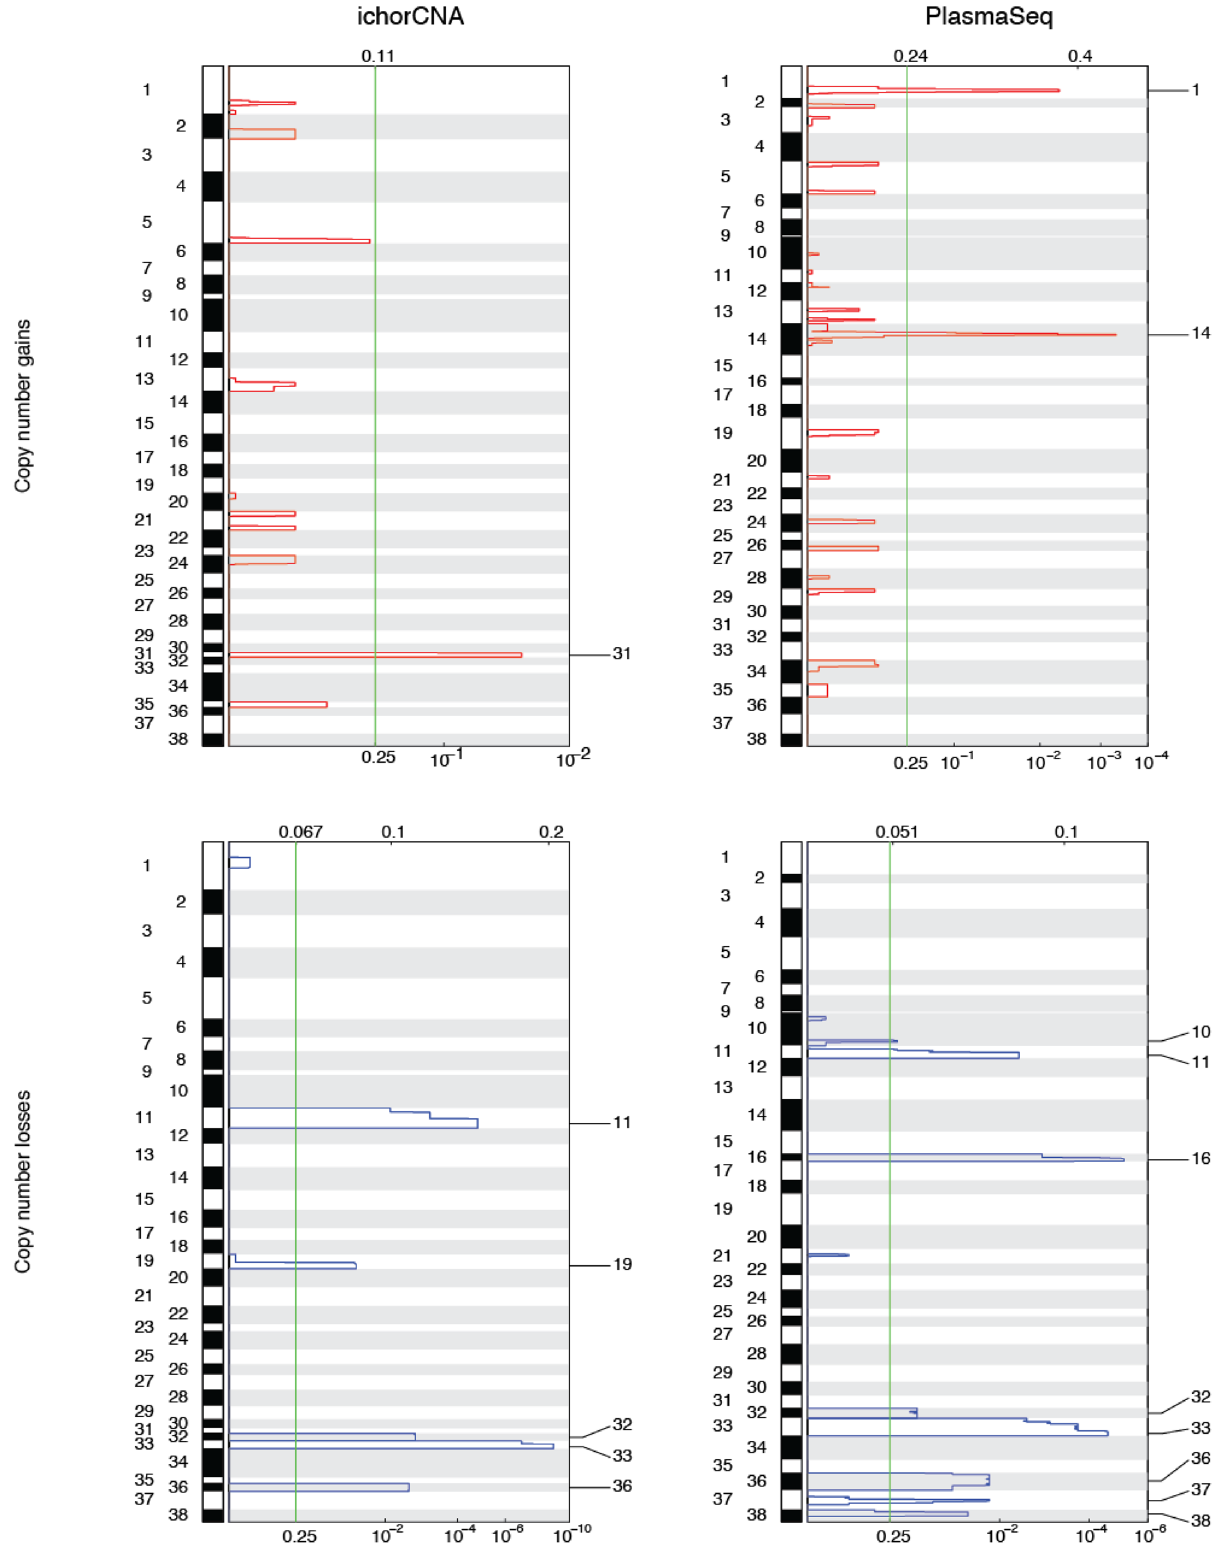
Figure 5. Assessment of significant recurrence for observed copy number gains (top) and copy number losses (bottom), using the two approaches, ichorCNA (left) and PlasmaSeq (right). Copy number deletions observed on chromosomes 11, 32, 33 and 36 were consistent across the two